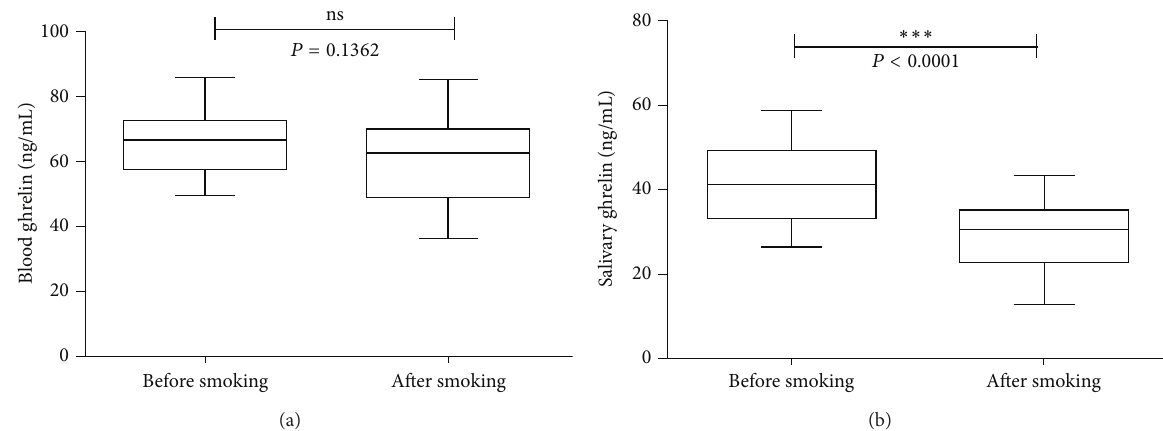
Figure 1: Comparison between blood and salivary ghrelin levels. Box and whiskers charts showing total ghrelin levels in blood (a) and saliva (b) before and after one-cigarette smoke. Data shown are geometric mean ± SEM of 𝑛 = 30